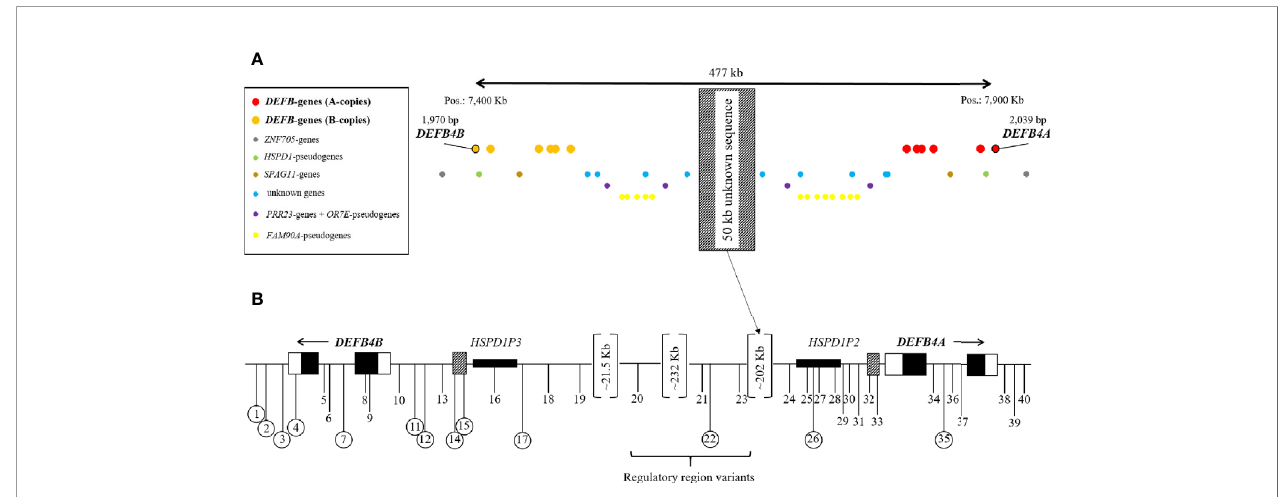
FIGURE 1 | DEFB4 locus on chromosome 8p23.1 with surrounding genes and pseudogenes (A) and location of the 40 selected SNPs for genotyping in GABRIELA Ulm (B) . (A) Red dots: A-copies of the b -defensin genes; orange dots: B-copies of the b -defensin genes; red and orange dots with black circle: DEFB4 genes. Blue dots: unknown genes; yellow dots: FAM90A -pseudogenes; purple dots: PRR23 -genes and OR7E -pseudogenes; brown dots: SPAG11 -genes; green dots: HSPD1 - pseudogenes; grey dots: ZNF705 -genes. The hatched rectangle in the middle represents a not yet sequenced 50 Kb area, which presents like a mirror in this cluster. (B) positions of the selected SNPs for genotyping are shown as black vertical lines with numbers in relation to the position of DEFB4A and DEFB4B . Circled numbers represent SNPs that were successfully genotyped. Black boxes refer to exonic regions, white boxes to UTRs, hatched boxes to putative promoter